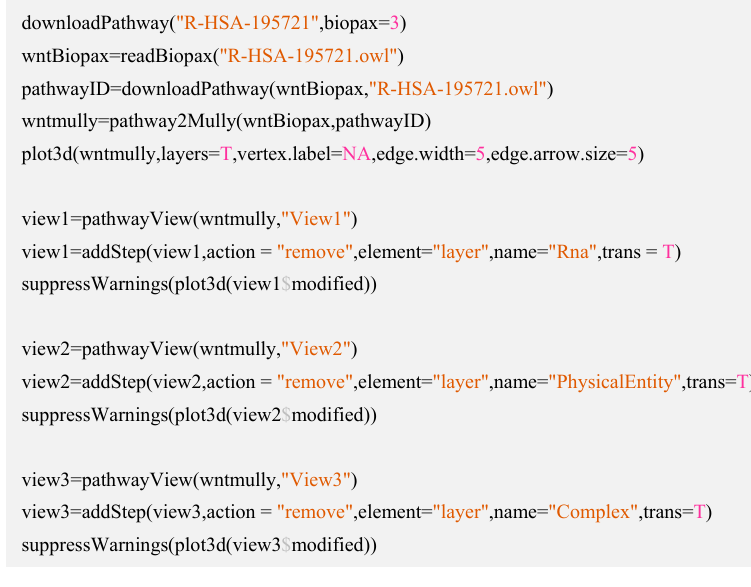
Figure 5. The script to generate and plot the model and the views. The function pathway2Mully() transforms the pathways parsed in the Biopax object into mully graphs. To plot the graph, we used the function plot3d() from the mully package, and finally, we generated the views using pathwayView() and modified them using the functions addStep() which applies a modification step to the